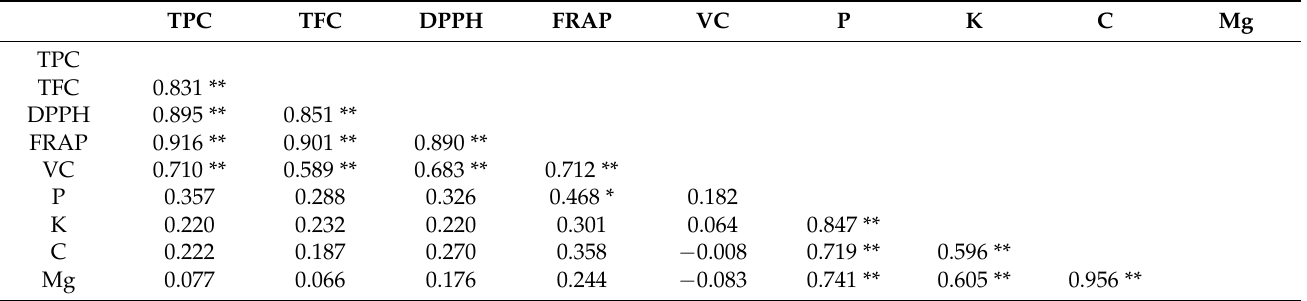
Table 4. Correlation between phytochemical, antioxidant activity and mineral contents of unripe apple